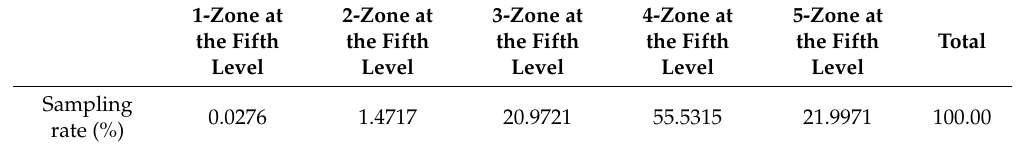
Table 1. Sampling rate of each zone at the fifth-level spatial resolution (162-m).